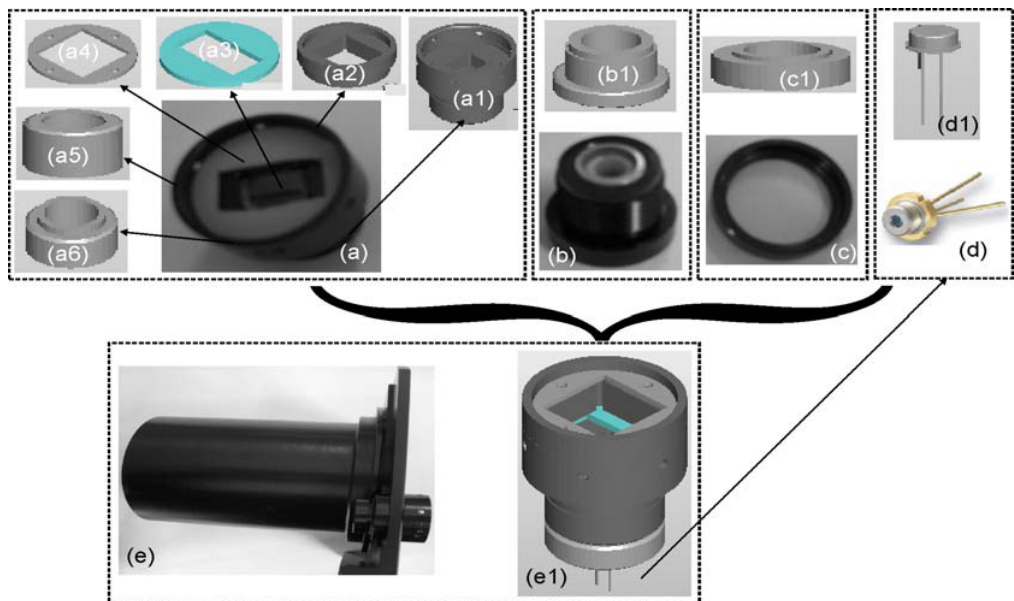
Figure 11. Hardware components of laser emitting